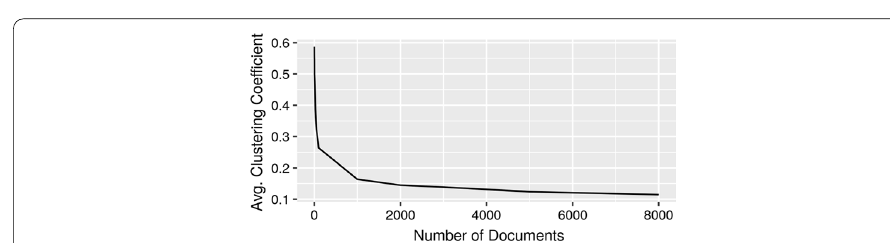
Fig. 6 Average estimated clustering coefficient over time for the base